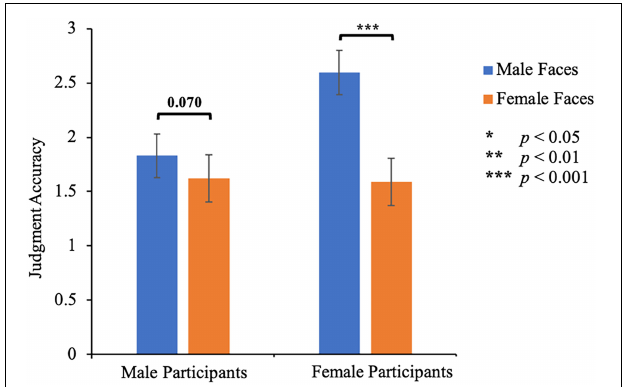
FIGURE 3 | Rating accuracy of facial attractiveness in Study 2. Error bars represent 1 S.E. of the